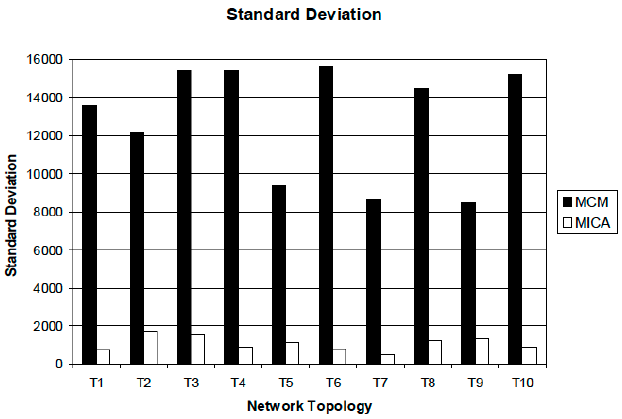
Figure 5. Standard deviation of all packets received by multi-receivers.